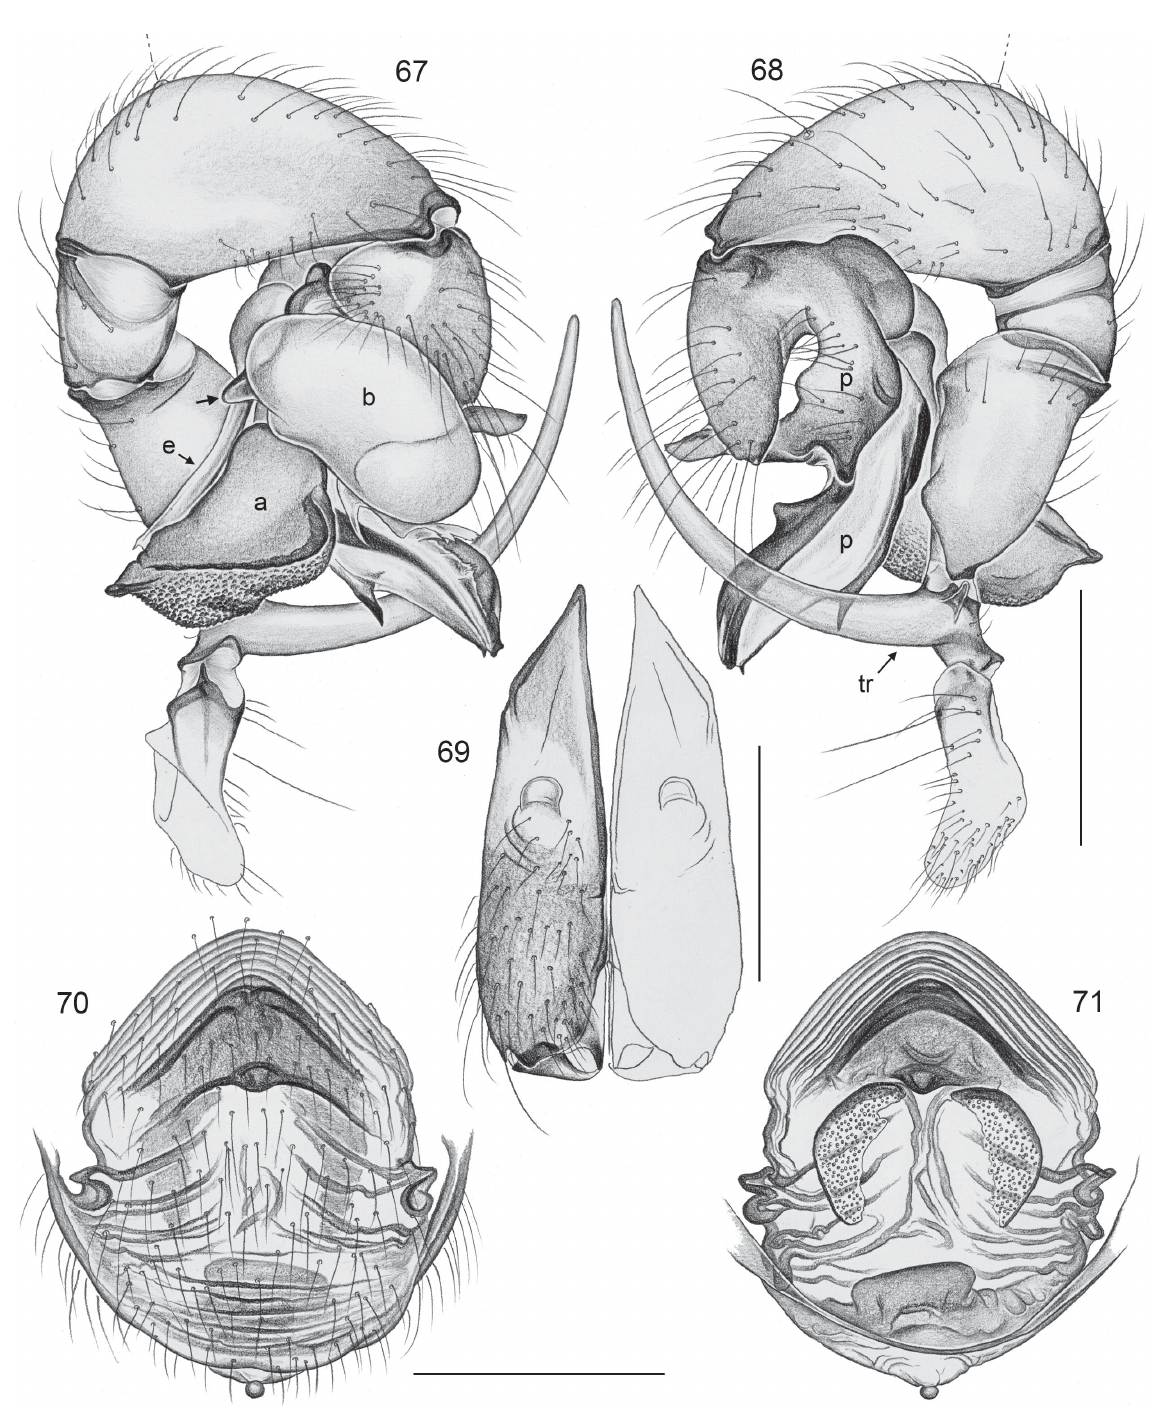
Figs 67–71. Pholcus bukittimah Huber sp. nov. (ZFMK, Ar 15706–07). 67–68 . Left male palp, prolateral and retrolateral views; arrow points at uncus-like process of proximal bulbal sclerite. 69 . Male chelicerae, frontal view. 70–71 . Cleared female genitalia, ventral and dorsal views. Scale bars: 67–68, 70–71 = 0.5 mm; 69 = 0.3